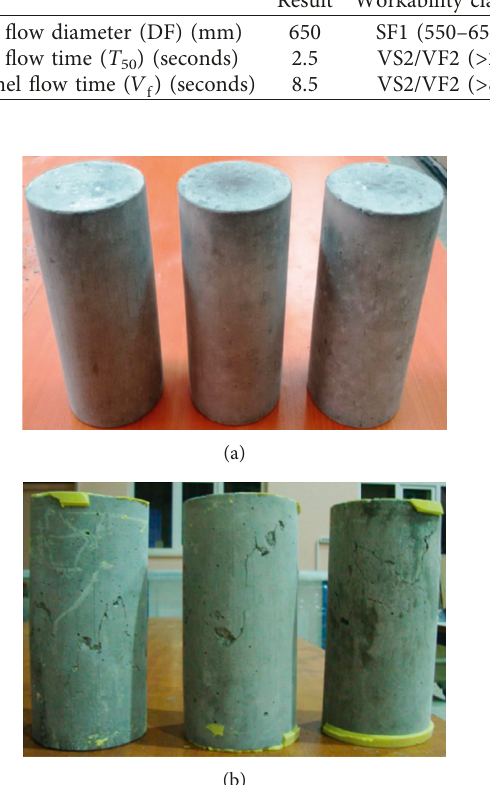
Figure 1: (a) Concrete cylinders before testing. (b) Concrete cylinders after testing.